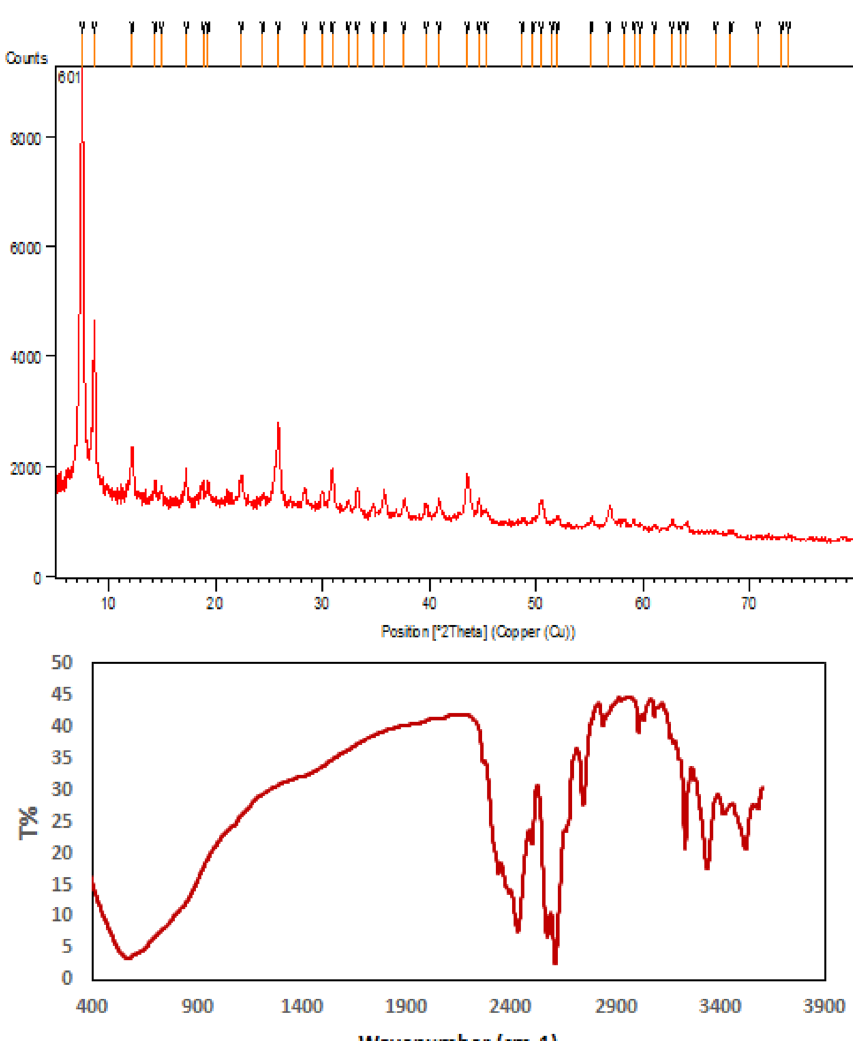
Figure 10. XRD and FT-IR data for reused UiO-66-biguanidine/Pd catalyst after 9